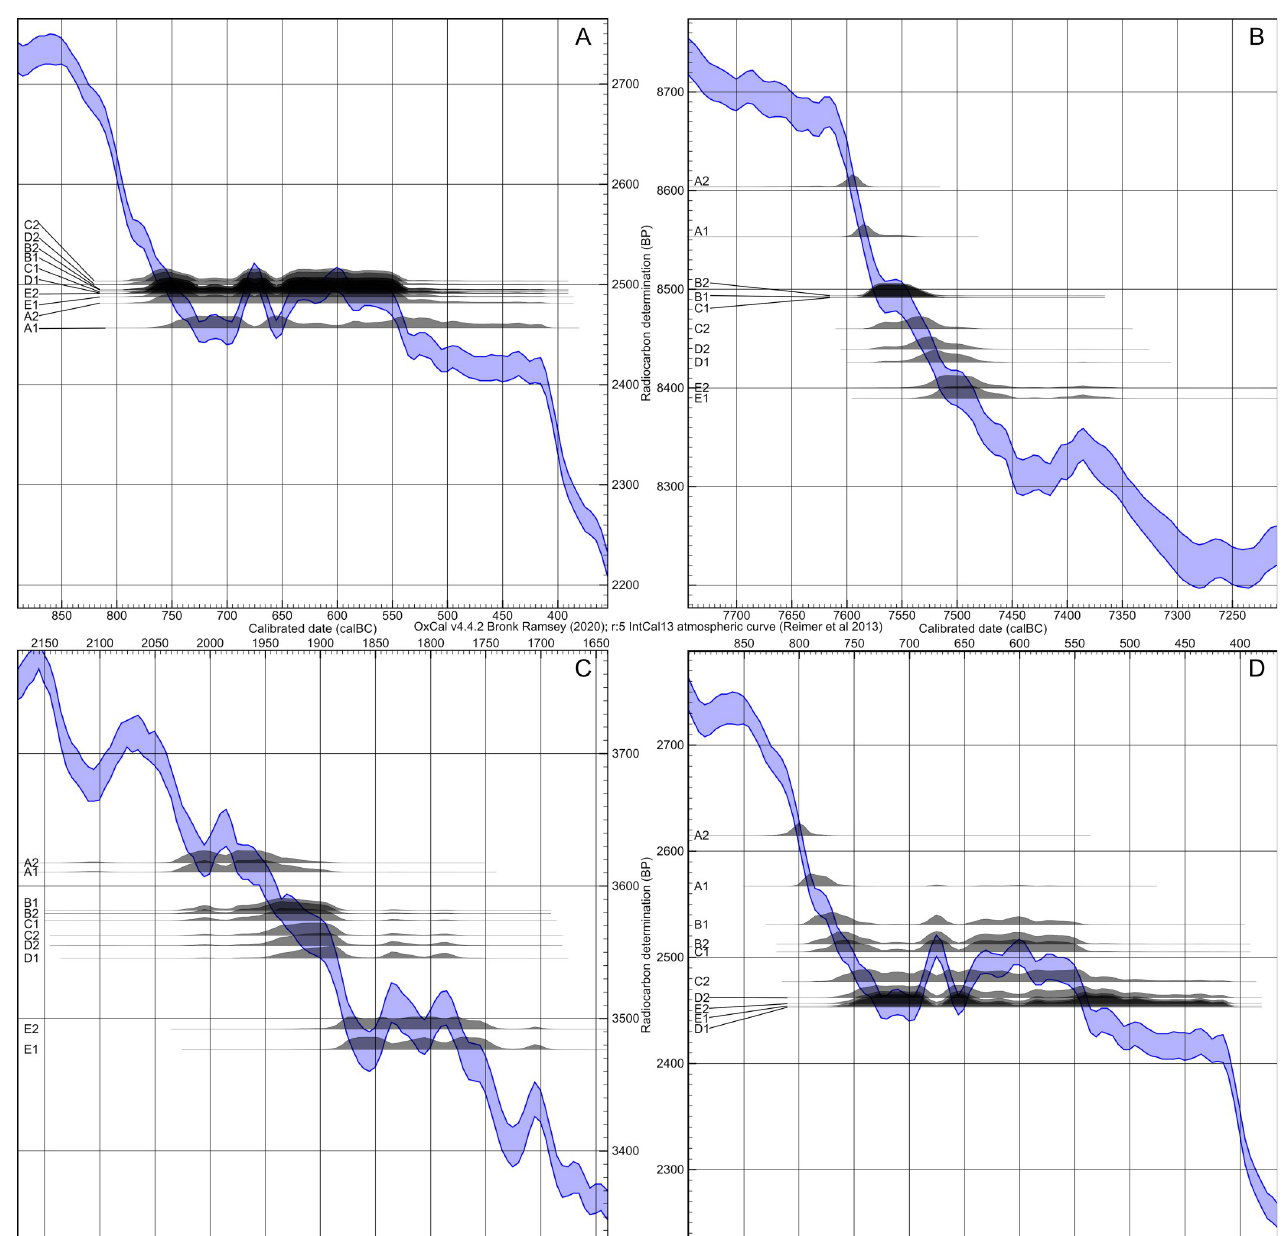
Fig 4. Calibration curves (IntCal13) and simulated dates of all four simulations. Plateau (A), steep (B), mixed (C) and anchor point (D) sections of the calibration curve (calibration results in Fig 5).